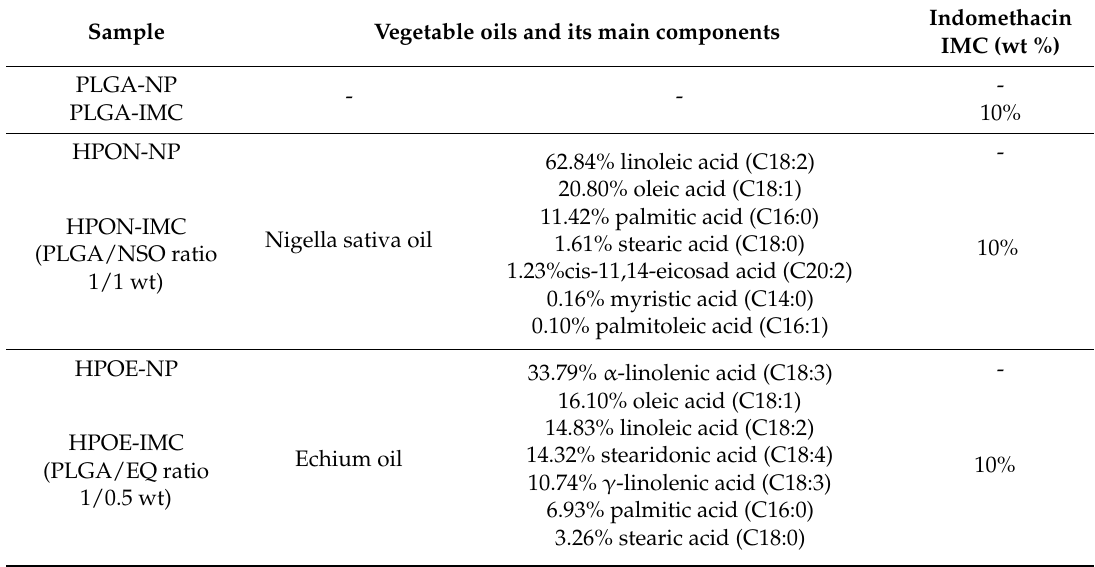
Table 1. Main composition of prepared standard or hybrid nanocarriers